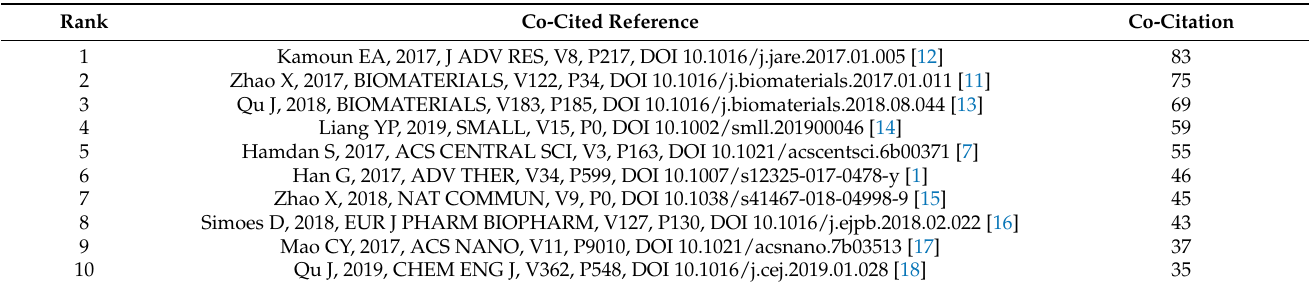
Table 4. Top 10 co-cited references related to nano-drug release in the wound healing field.